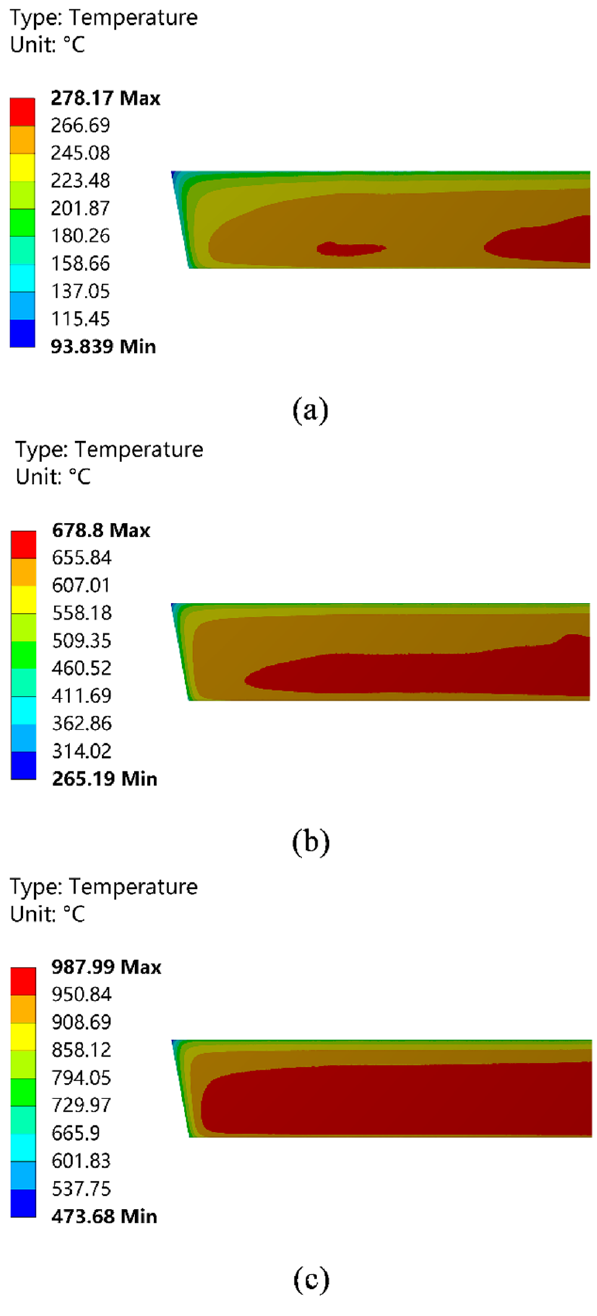
Figure 3. Temperature field distribution of the cold surface of the working layer. ( a ) The first stage of preheating; ( b ) the second stage of preheating; and ( c ) the third stage of preheating.